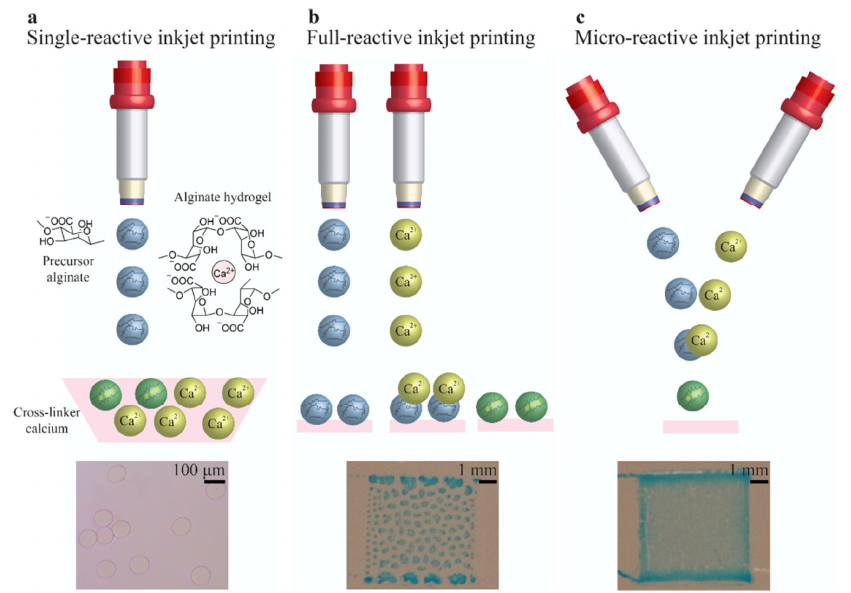
Figure 4. Three different strategies of jet-based bioprinting approaches to create alginate hydrogels. Blue dye is used to visualize the deposited alginate hydrogel. ( a ) Single-reactive printing involves direct deposition of the precursor into a crosslinker. ( b ) Full-reactive printing of the precursor followed by the crosslinker, creating the finished hydrogel (green). ( c ) Micro-reactive inkjet printing, whereby crosslinker and precursor meet midair, and a hydrogel is formed before deposition. Reproduced with permission from [77], the American Chemical Society, 2020.